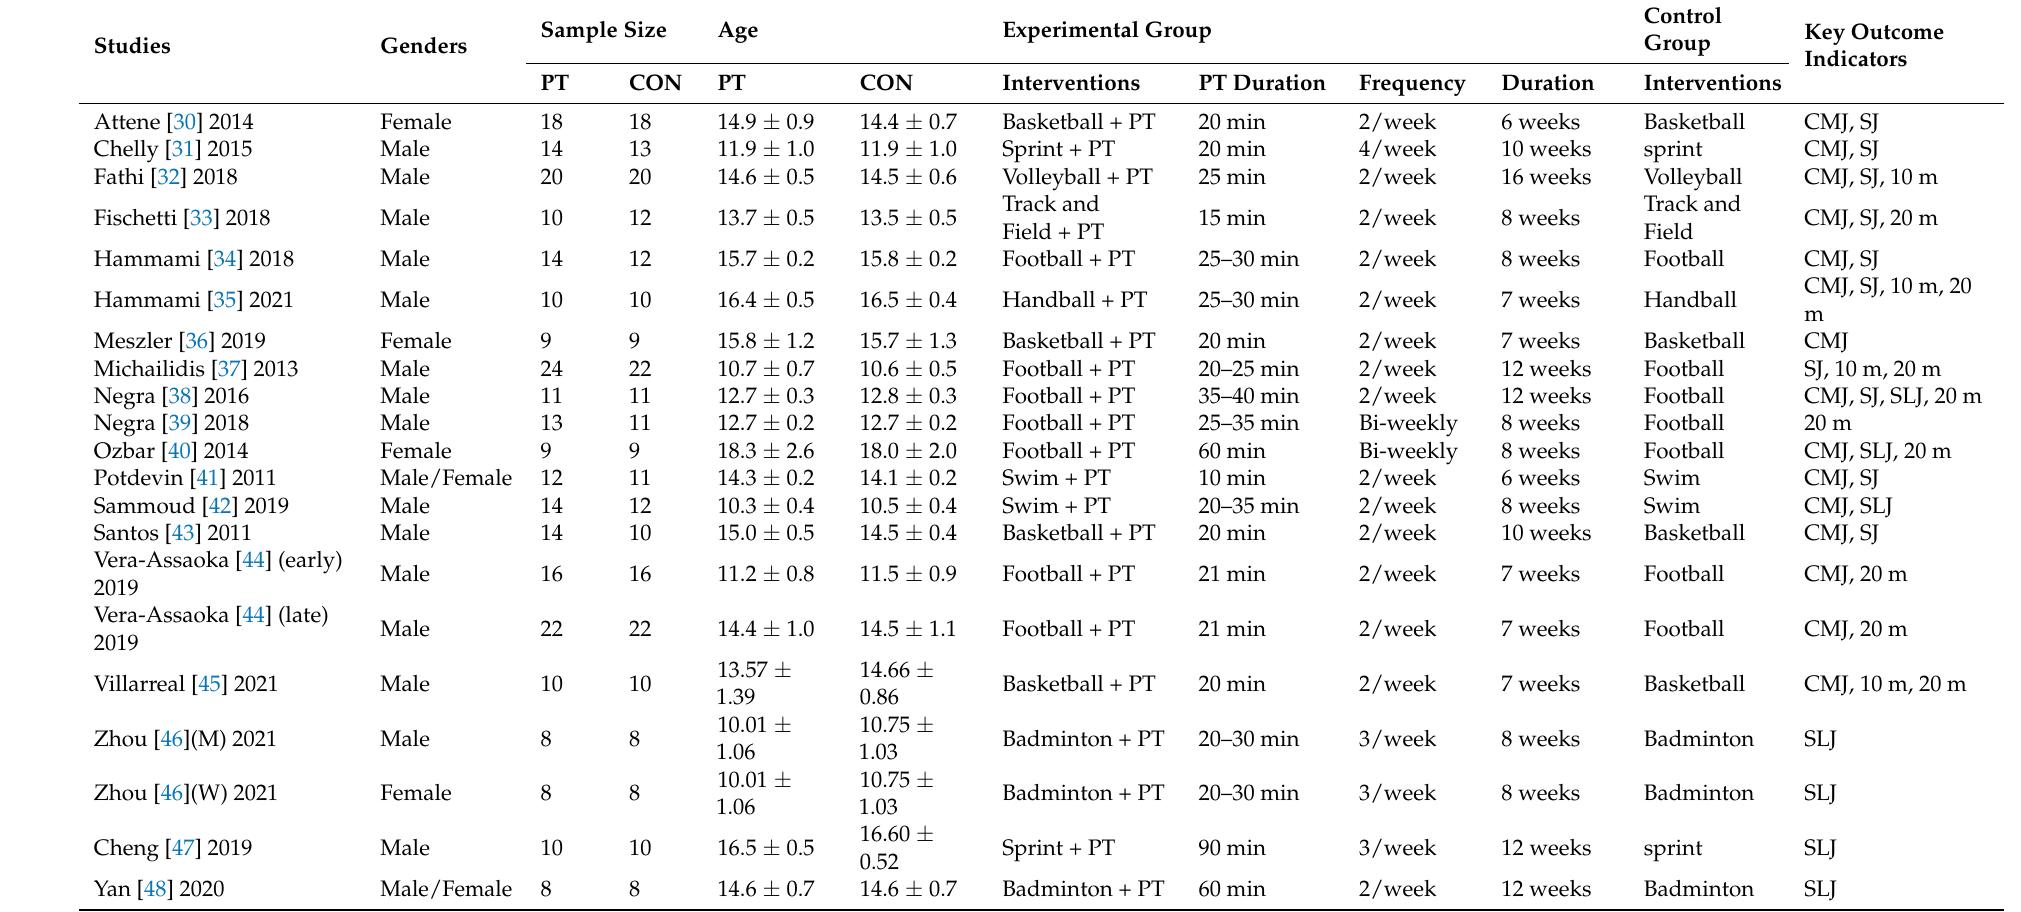
Table 1. Characteristics of study